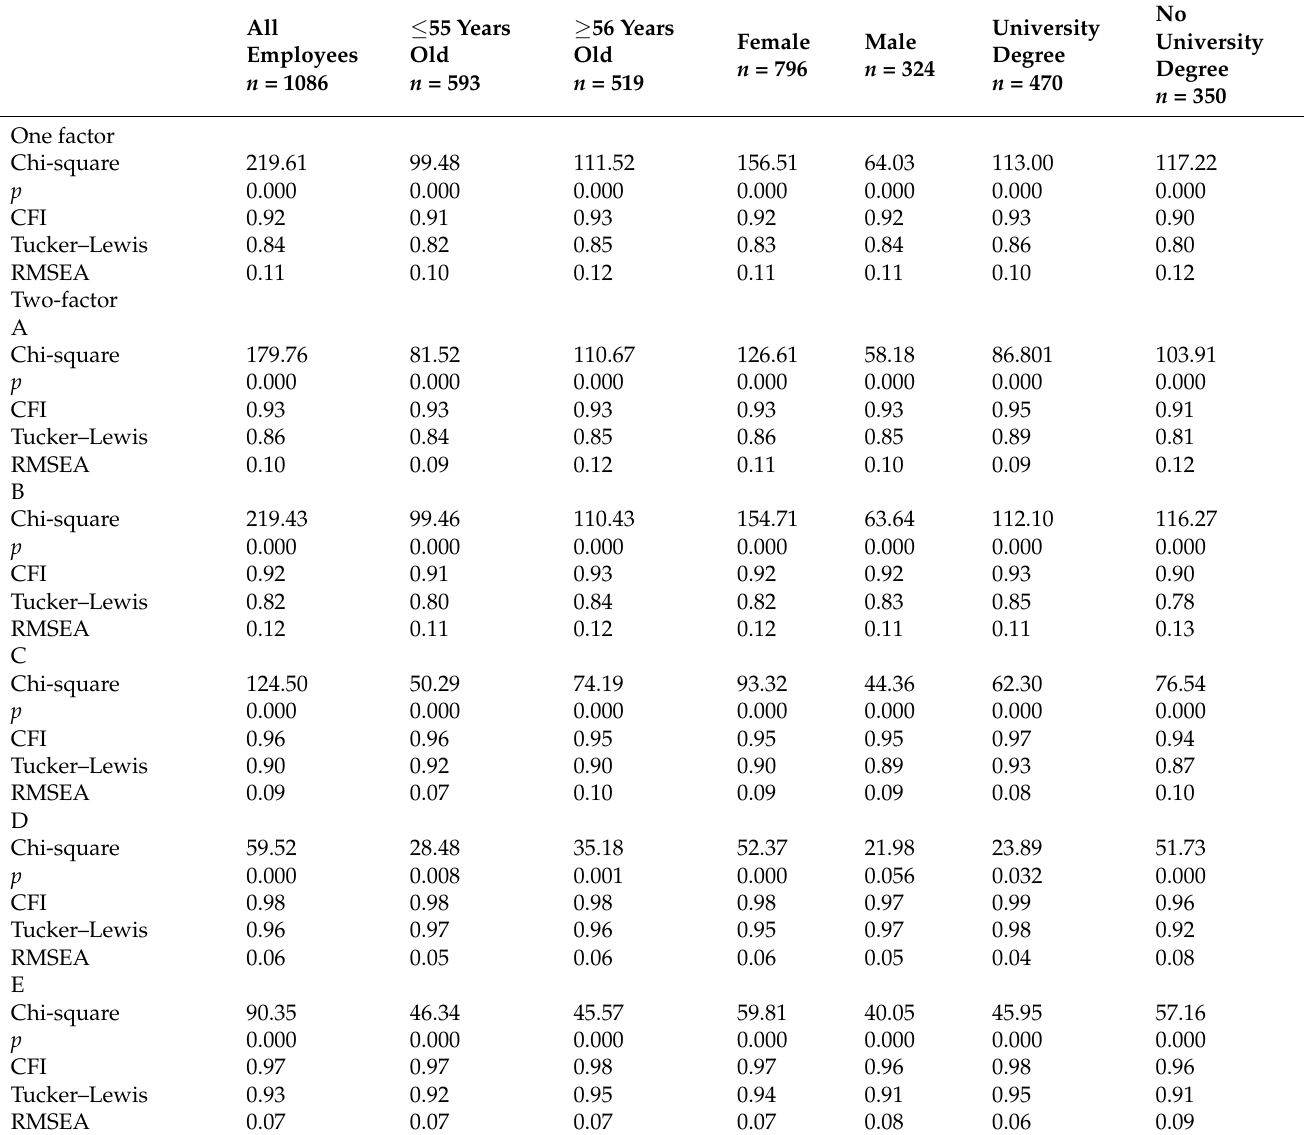
Table 3. Confirmatory factor analysis results—fit of various